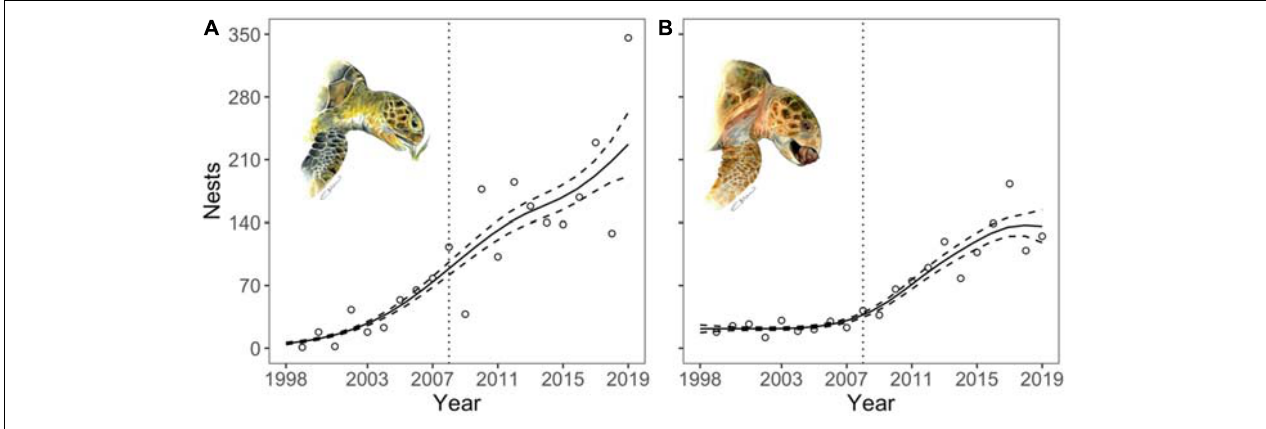
FIGURE 2 | Temporal variation in nest counts for green (A) and loggerhead (B) turtles in Grand Cayman over the study period (1999–2019). Nest counts are show by the dots. Solid lines denote model predictions and dashed lines show standard errors. The dotted vertical lines indicate the end of the Cayman legal turtle fishery for mature green and loggerhead turtles. Artwork: Emma